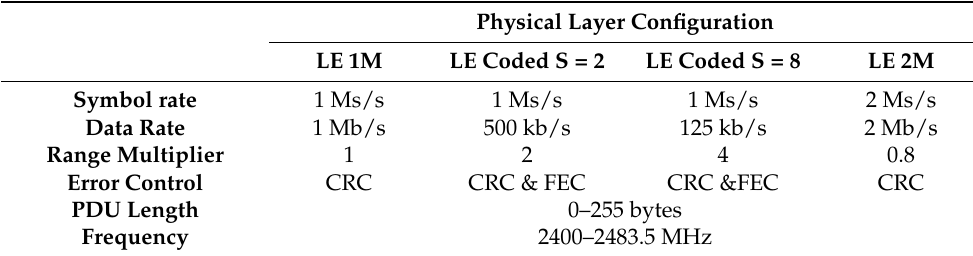
Table 2. Types of communication in vehicular and Smart City